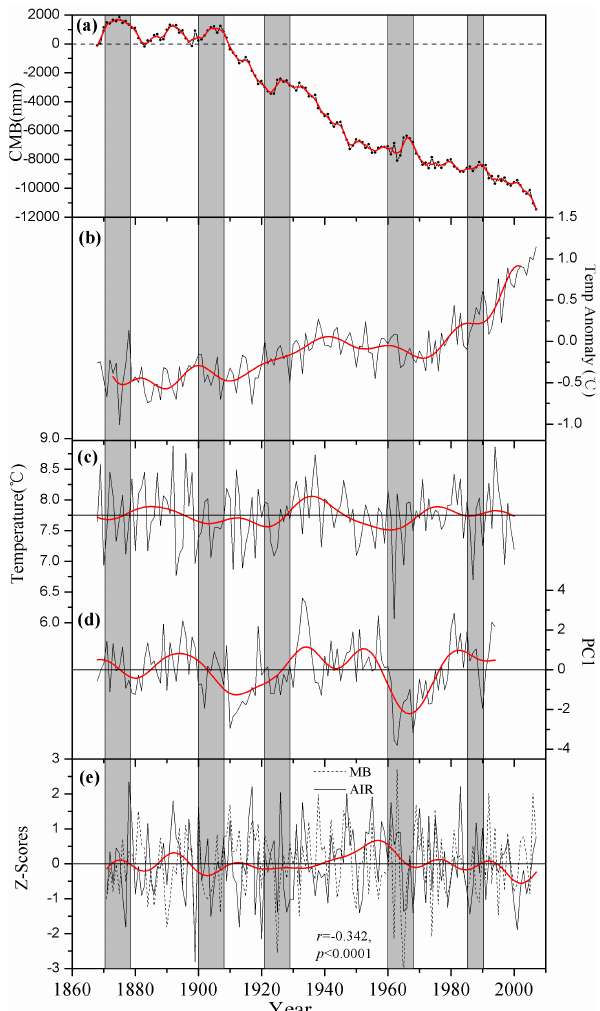
Fig. 3. (a) Cumulative mass balance (CMB) variation (black dot- ted line) at the Hailuogou Glacier back to 1868, with a 3-point moving average (red line). (b) Northern Hemisphere annual tem- perature anomaly (HadCRUT4) over the period 1868–2007 (black line), with a 10yr FFT (fast Fourier transform) filter (red line). (c) August–September temperature reconstruction for the eastern Tibetan Plateau (letter C in Fig. 1a) during 1868–2000 (Wang et al., 2010), with a 10yr FFT filter (red line). (d) Reconstructed winter temperature variability (PC1) in the West Sichuan Plateau (letter B in Fig. 1a) (Shao eand Fan, 1999) during the period 1868–1994, with a 10yr FFT filter (red line). (e) Comparison of the recon- structed MB (was multiplied by − 1) with August–September all- India monsoon precipitation over the period 1871–2007. Red line indicates 10yr FFT filter of the